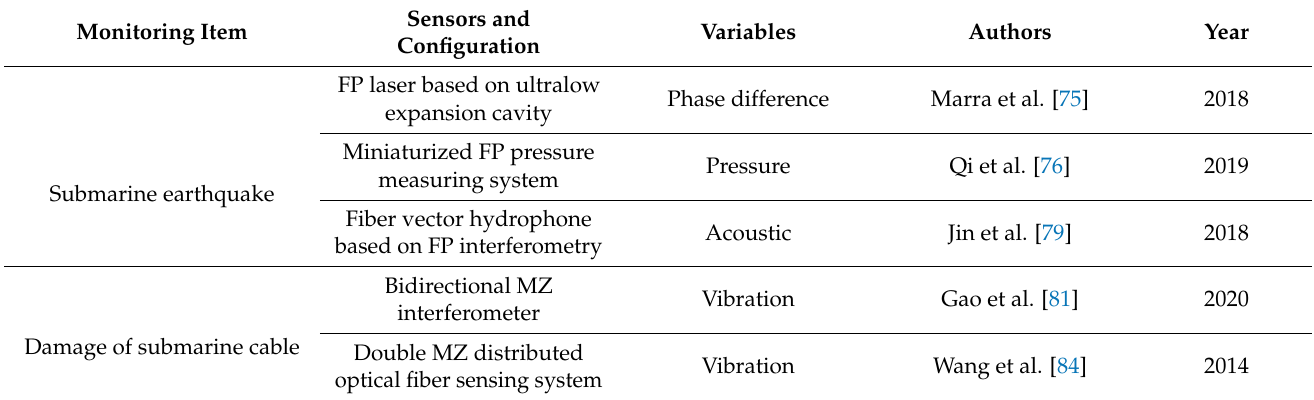
Table 1. Interferometric OFSs for SHM.